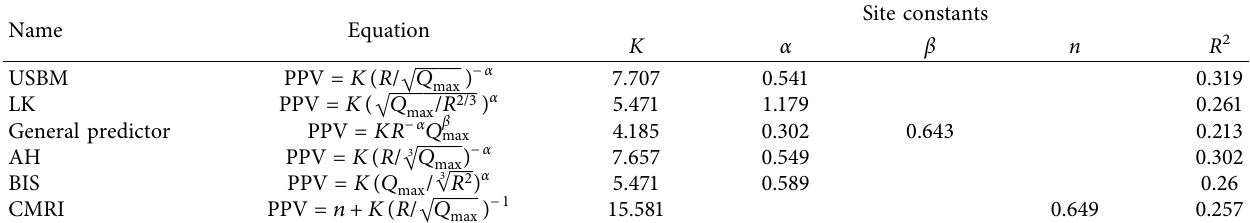
Figure 5: Relationship between PPV and scaled distance of the conventional empirical formulas. (a) Relationship between PPV and scaled distance of the USBM empirical formula. (b) Relationship between PPV and scaled distance of the LK empirical formula. (c) Relationship between PPV and scaled distance of the general predict empirical formula. (d) Relationship between PPV and scaled distance of the AH empirical formula. (e) Relationship between PPV and scaled distance of the BIS empirical formula. (f) Relationship between PPV and scaled distance of the CMRI empirical formula. Table 4: The conventional empirical formulas and their site